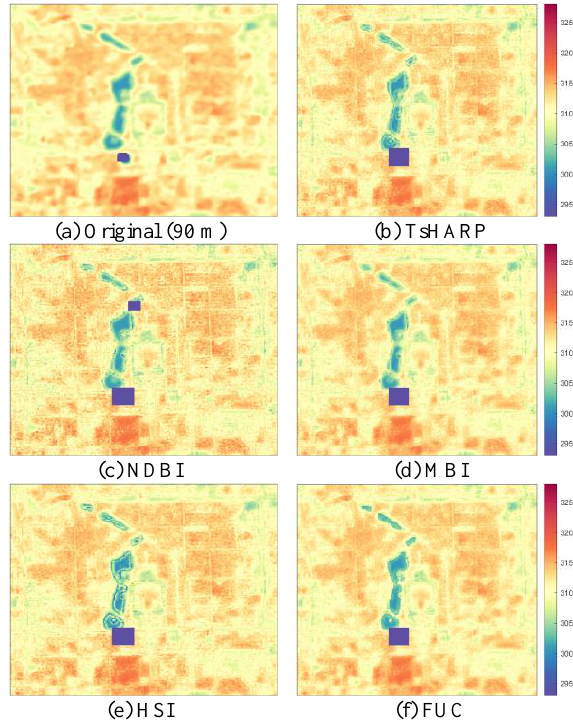
Figure 4. Sharpened images of the Forbidden City palace complex and nearby urban area from 06/14/2019 images using the urban